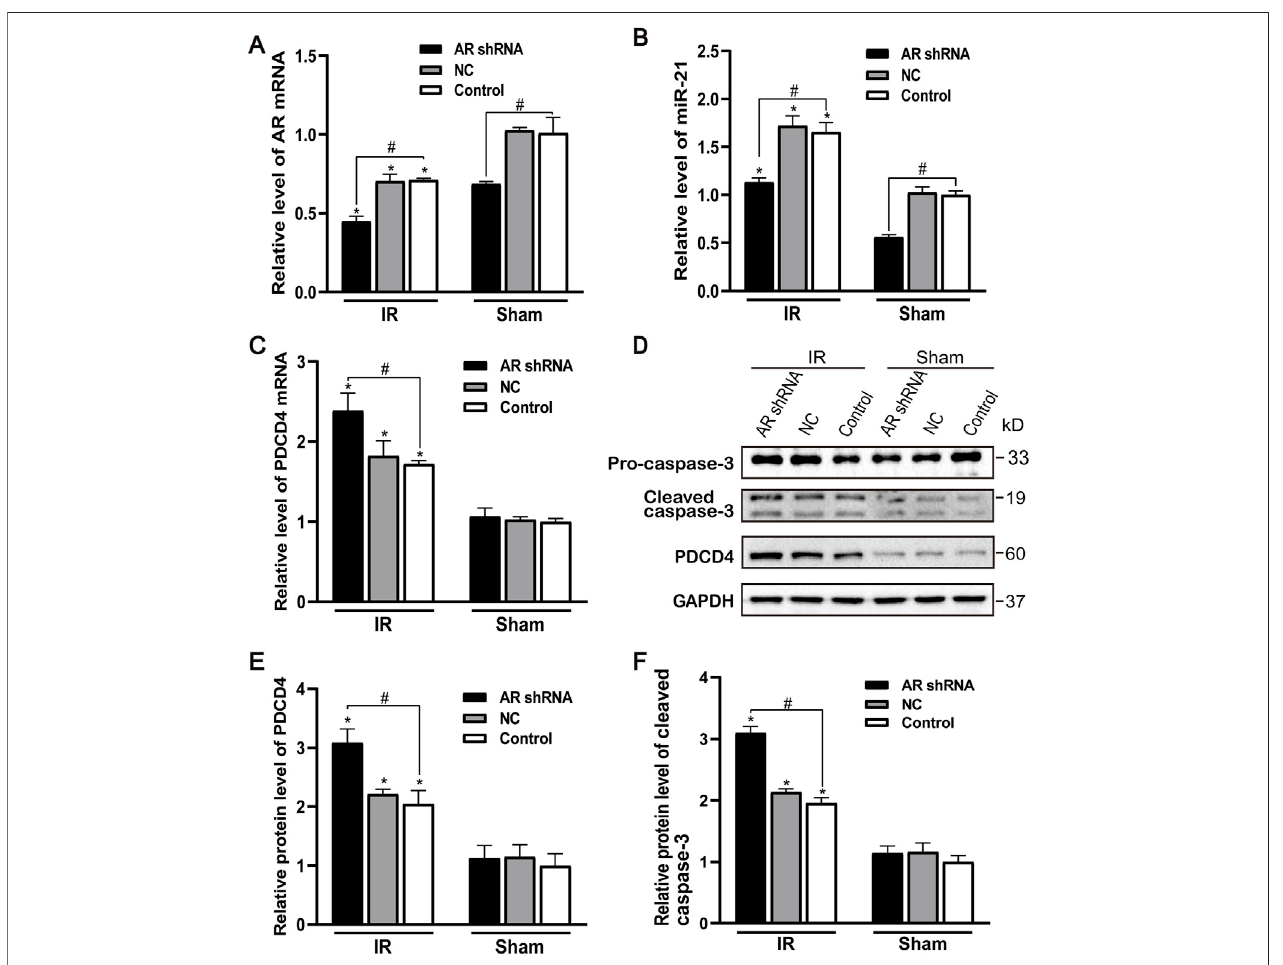
FIGURE 4 | Effect of silencing AR expression on miR-21 level and renal tubular cell apoptosis. (A) qPCR showing knocking down AR decreased AR mRNA level after renal ischemia-reperfusion injury in male mice. (B) Silencing AR decreased miR-21 level after renal ischemia-reperfusion injury. (C) Silencing AR increased PDCD4 mRNA level renal after ischemia-reperfusion injury. (D) Western blot showing knocking down AR increased cleaved caspase-3 and PDCD4 protein levels in renal tissue afterrenalischemia-reperfusion. (E) QuantitativeevaluationofPDCD4proteinlevelsinrenaltissue. (F) Quantitativeevaluationofcleavedcaspase-3proteinlevelsin renal tissue. Data presented are mean ± SEM ( n > 5). Compared with sham operation group, * p < 0.05. Compared with Control + IR group, # p < 0.05.